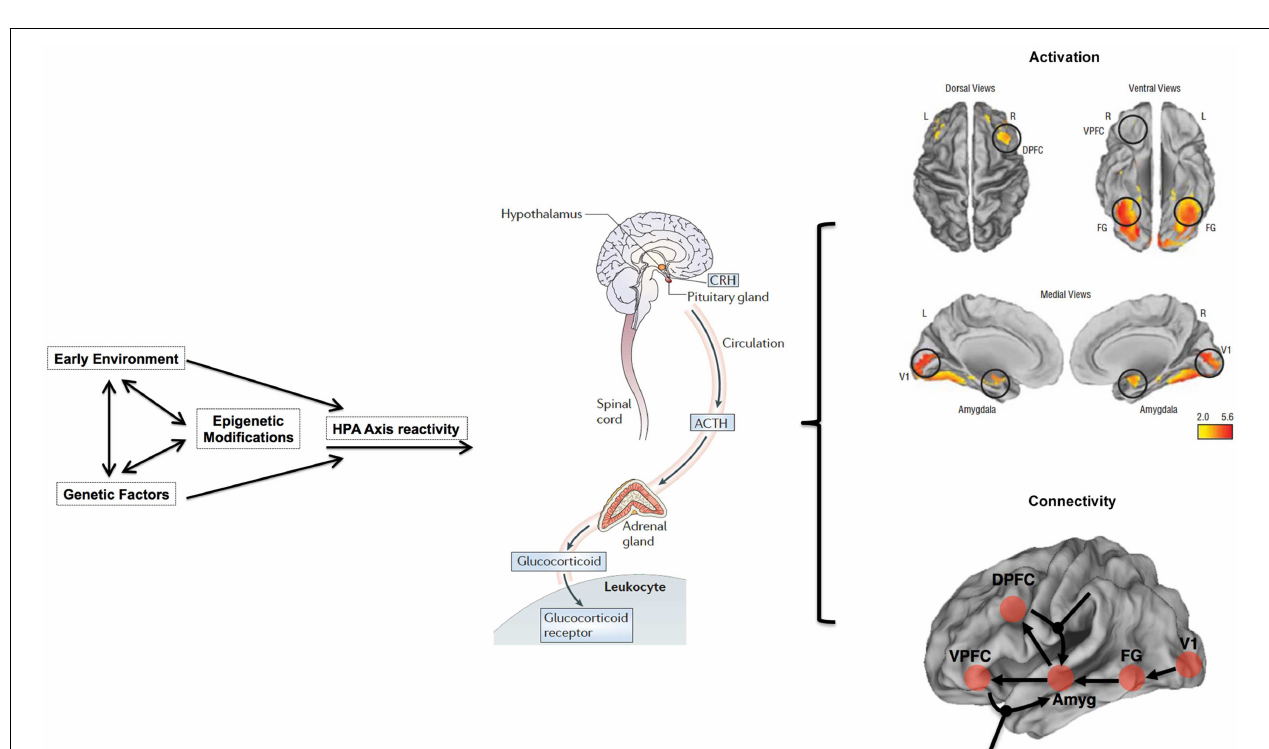
activations are most likely generated by complex dynamic interactions between brain networks that are represented in the figure below.The figure presents a putative combination of intrinsic connections between brain regions activated during such a task, and the contextual modulation of specific intrinsic connections by dynamic task elements.The role of effective connectivity analyses is to recover and estimate parameter values for intrinsic and modulatory connections that a) may be different in the diseased or risk state and b) may plausibly be under epigenetic mediation. The figure is adapted and reprinted from: Mehta and Binder (124), with permission from Elsevier; adapted by permission from Macmillan Publishers Ltd.: Frontiers in Neuropsychiatric Imaging and Stimulation (108). Reproduced with permission, Copyright ©(2012) American Medical Association. All rights